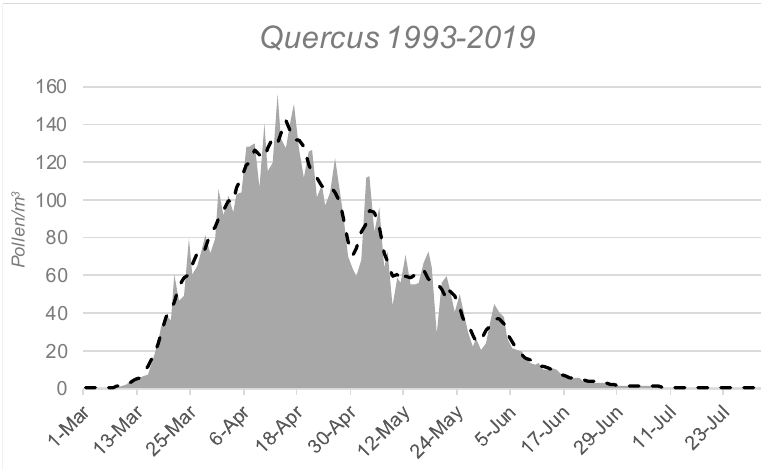
Figure 3. Average daily values of airborne Quercus pollen concentration in the atmosphere of Ourense from 1993 to 2019 (in line represent the 5 days running mean).